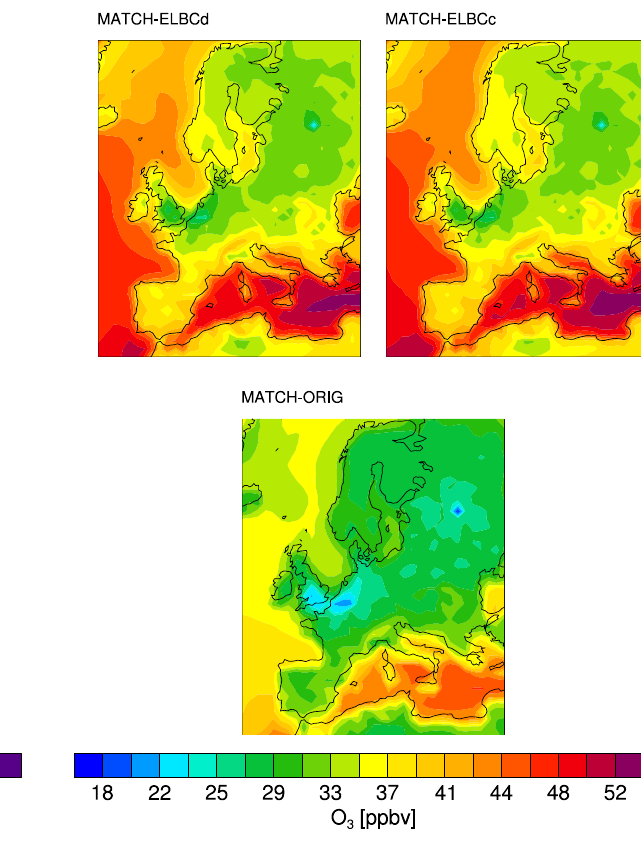
Figure 7. Same as Fig. 6, but for O 3